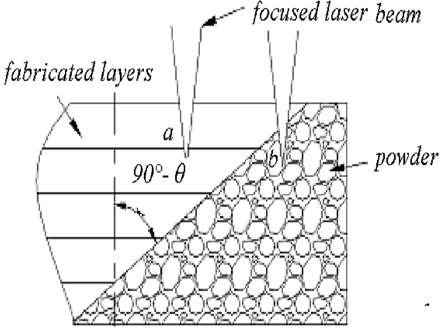
Figure 8. Illustration of laser scanning the overhang.